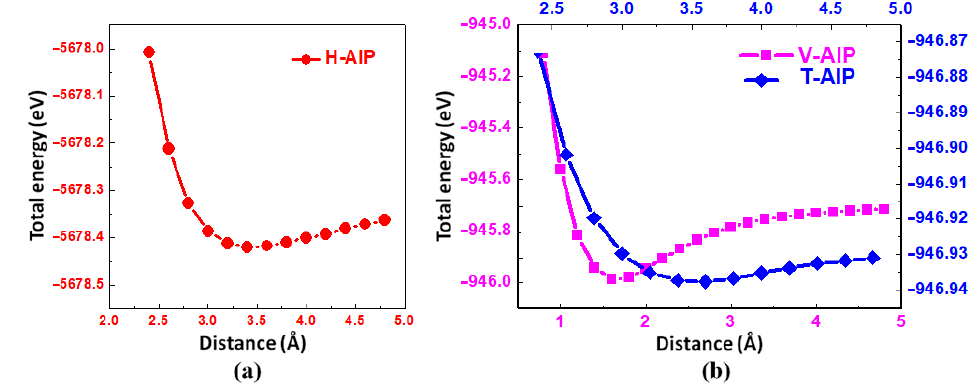
Figure 2. The total energy of the three systems versus the interlayer distance. ( a ) The case for T/V-AlP bilayers; ( b ) the case for T-AlPand V-AlP bilayers.